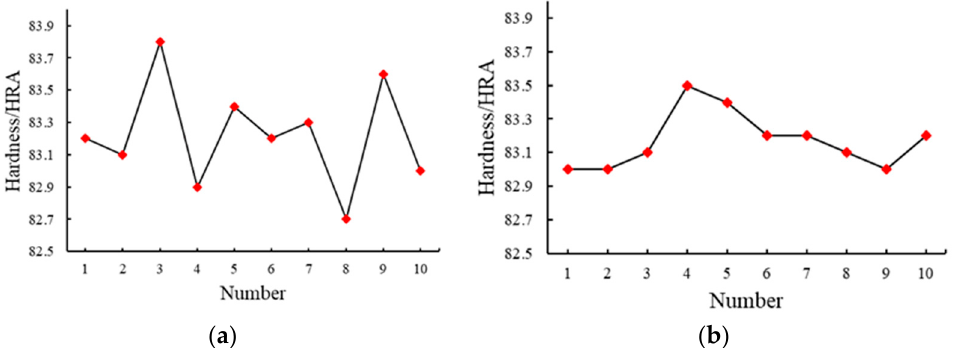
Figure 10. The hardness of the disc cutter after the heat treatment: ( a ) Salt bath quenching; ( b ) Vacuum quenching.